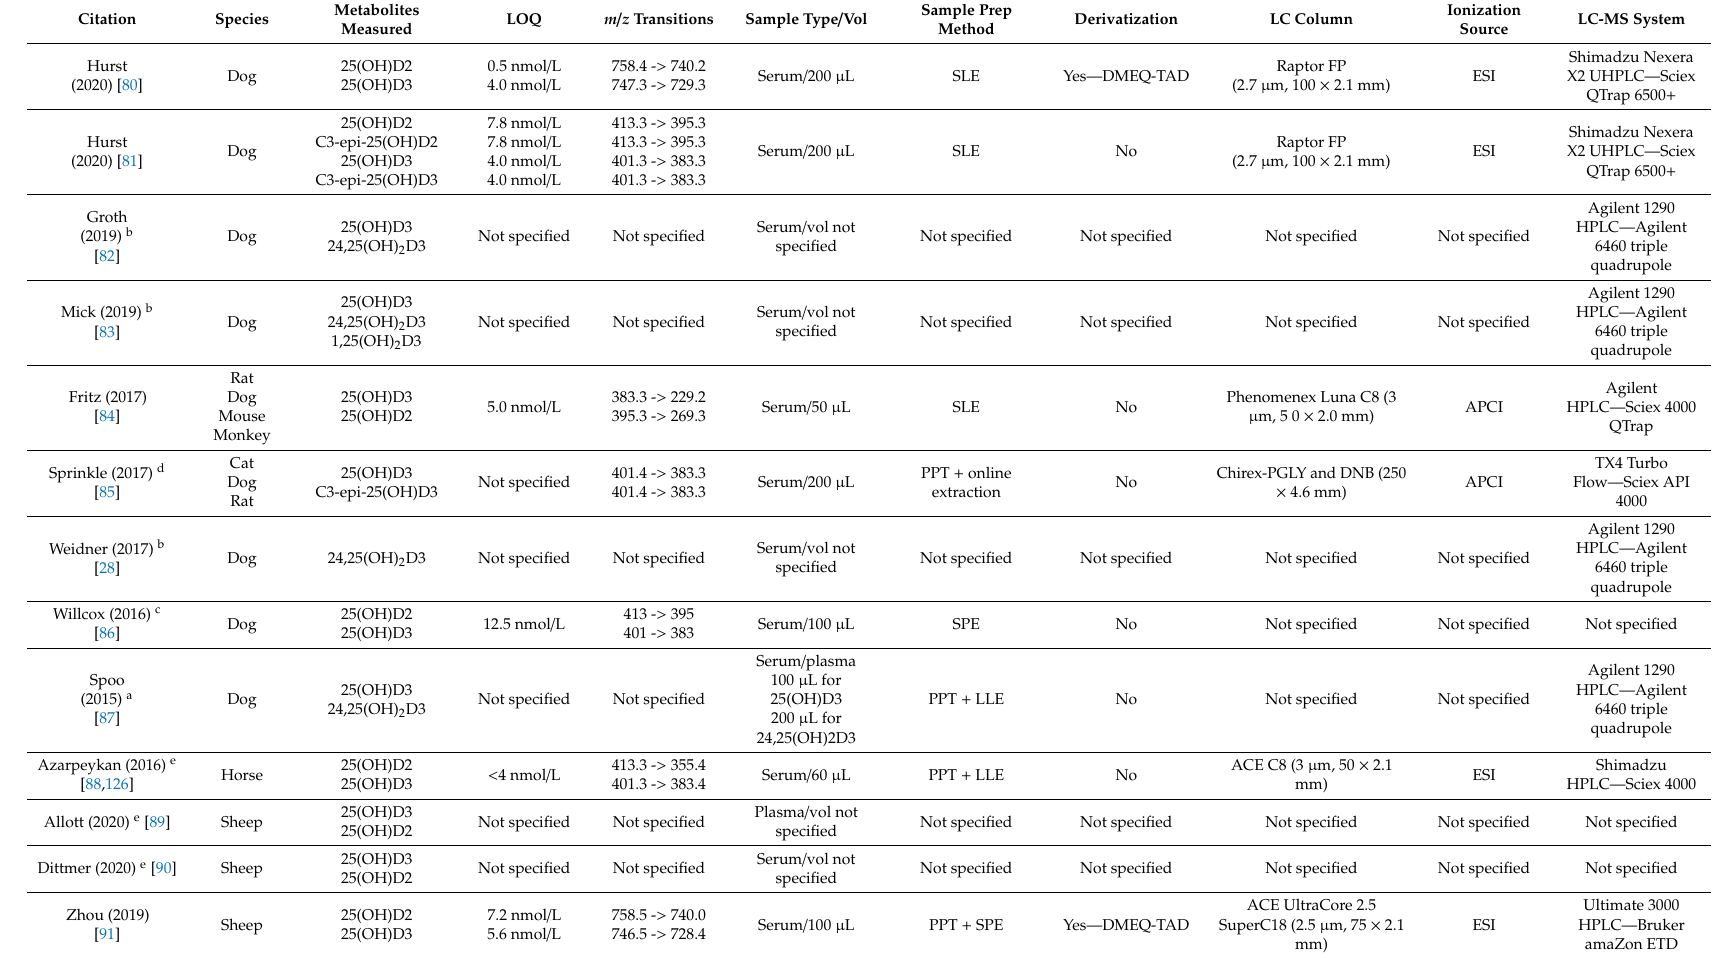
Table 1. Details of reported LC-MS / MS assays for the analysis of veterinary